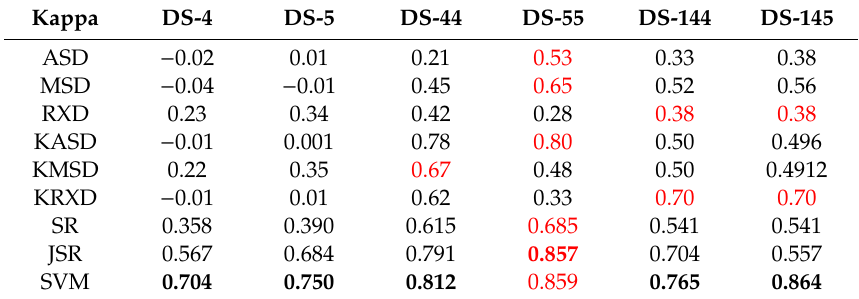
Table 5. Kappa coe ffi cient ( κ ) of each method and band combination. Red numbers indicate the best accuracy for each method and bold numbers indicate the best accuracy for each dataset.